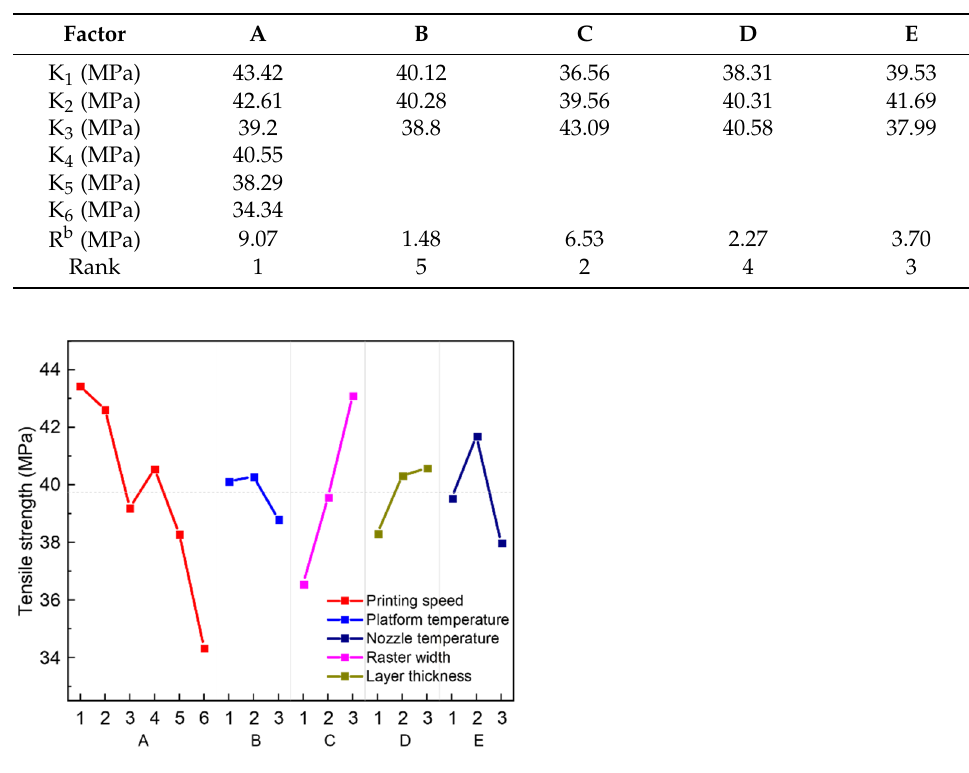
Figure 6. Main effects plot: relationship between tensile strength and factors with different levels.